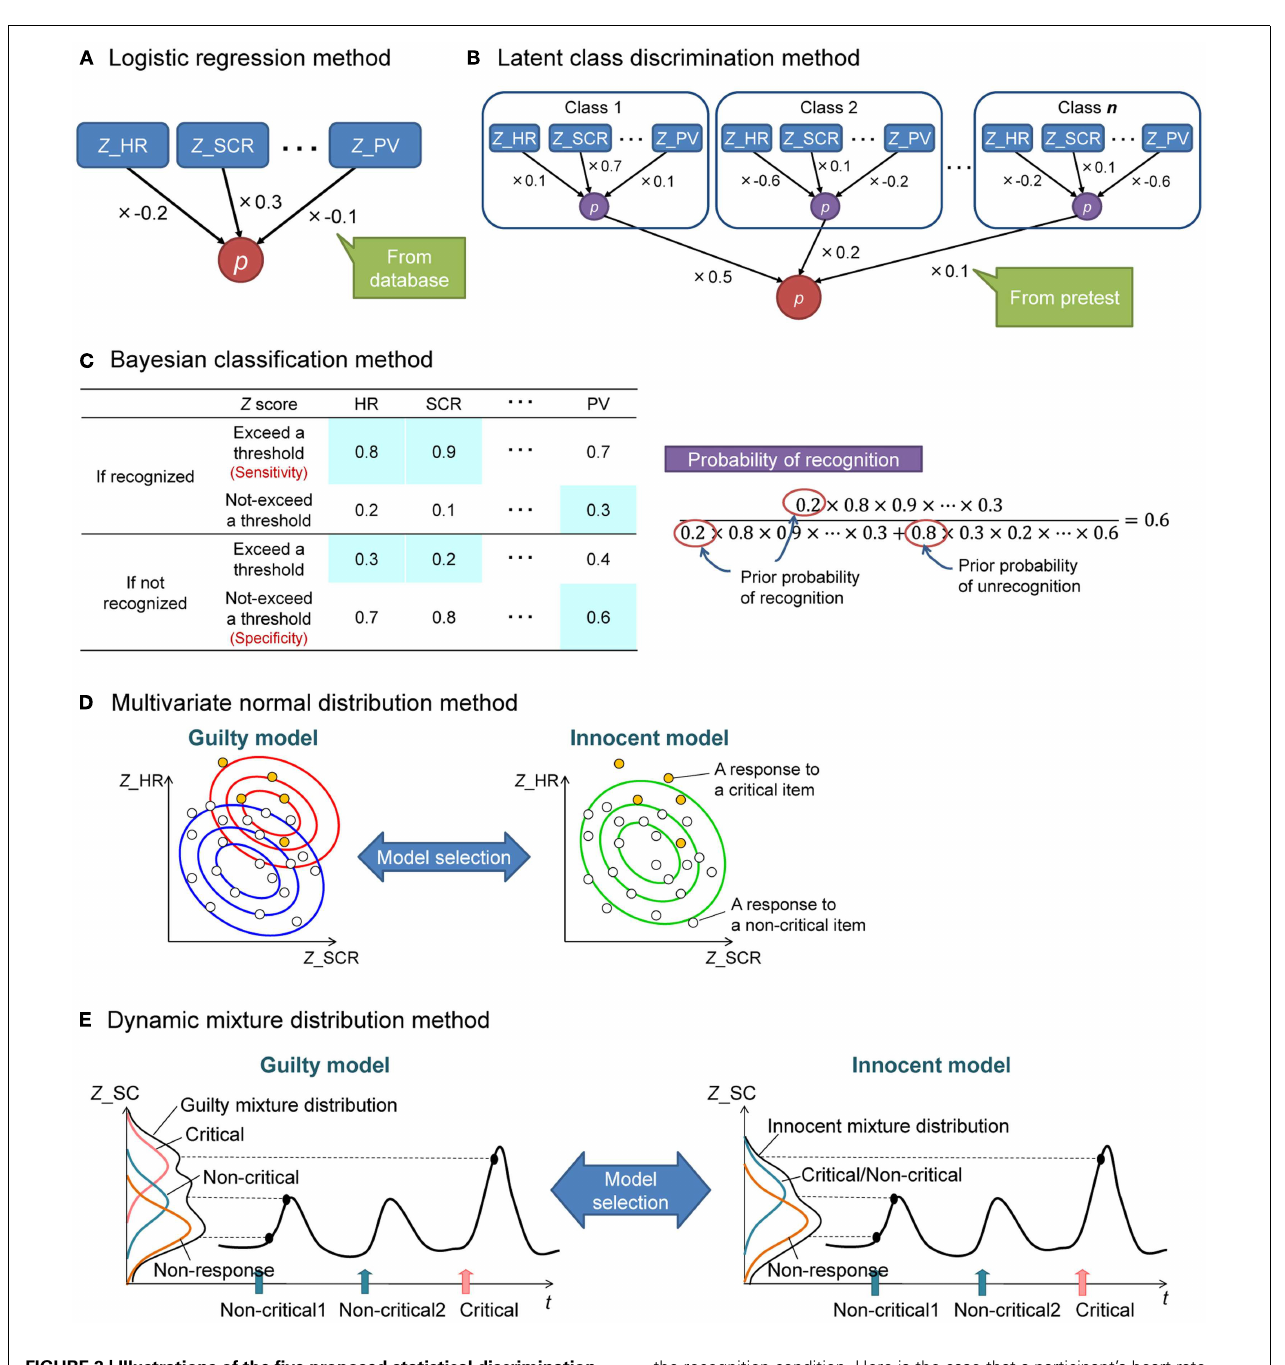
FIGURE 2 | Illustrations of the five proposed statistical discrimination methods. Z _HR, a z -score of heart rate; Z _SCR, a z -score for skin conductance response; Z _PV, a z -score for pulse volume; p, probability. (A) The logistic regression method is similar to z- score averaging, but each z- score is weighted according to the accuracy of the measure estimated from previous datasets. (B) The latent class discrimination method is a two-layer model of the logistic regression method.There is an appropriate regression formula for each class, and the result of the regression formula is summed across classes with a weight of the likelihood of an examinee belonging to a class according to his/her pretest result. (C) The Bayesian classification method calculates the probability of recognition by multiplying prior probabilities and the probabilities that a standardized response value of each measure exceeds/does not exceed a threshold in